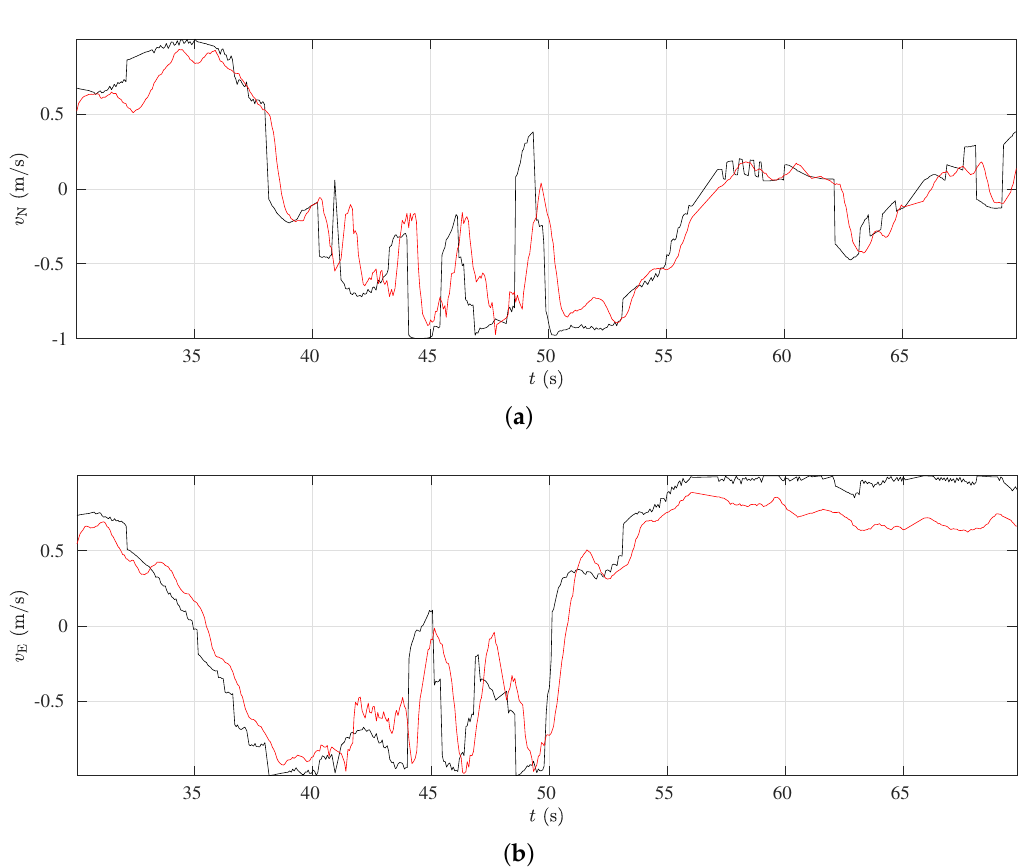
Figure 14. Attitude controller results. ( a ) Velocity in the north direction and ( b ) velocity in the east